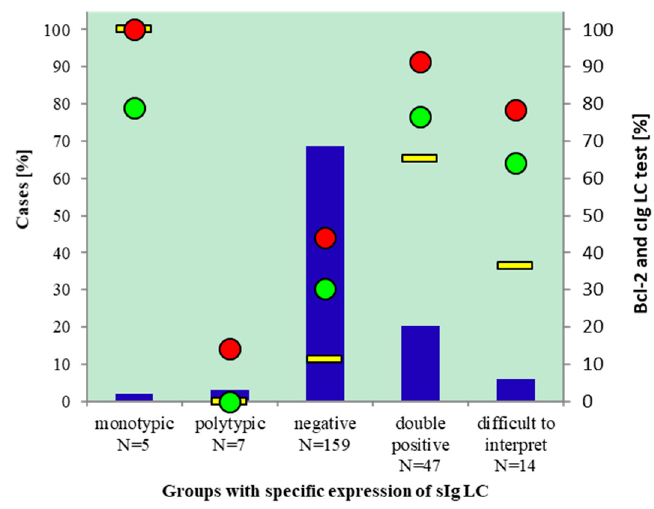
Figure 4. Performance of Bcl-2 and cIg LC tests for diagnosing BCL in cases with inconslusive sIg LC. Samples with conclusive and inconclusive sIg LC (blue columns, left axis), % BCL (red dots, right axis), % monotipic cIg LC (yellow line, right axis), % positive Bcl-2 test (green dots, right axis).